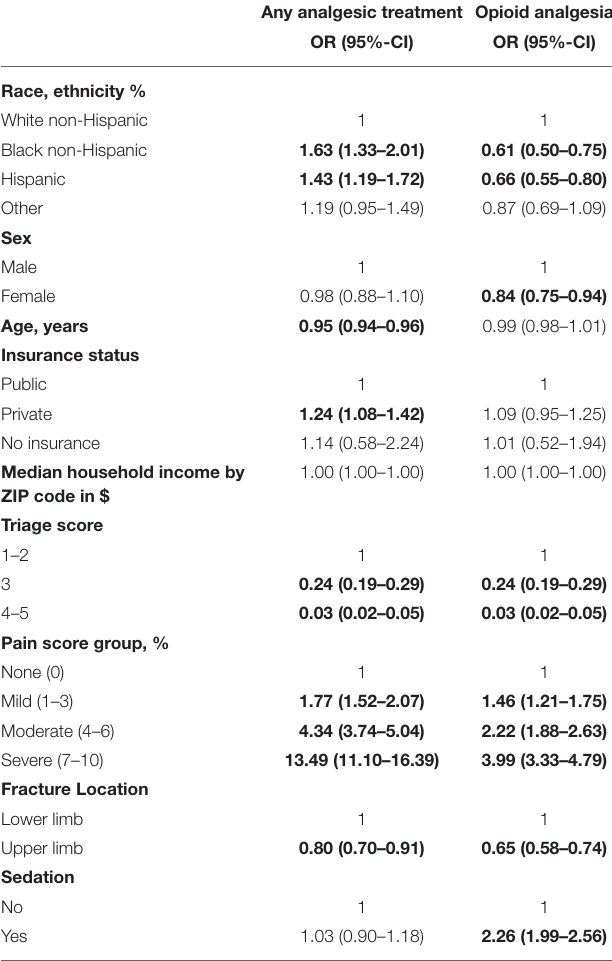
TABLE 4 | Visit characteristics of children with suspected appendicitis ( N = 4,780) a .